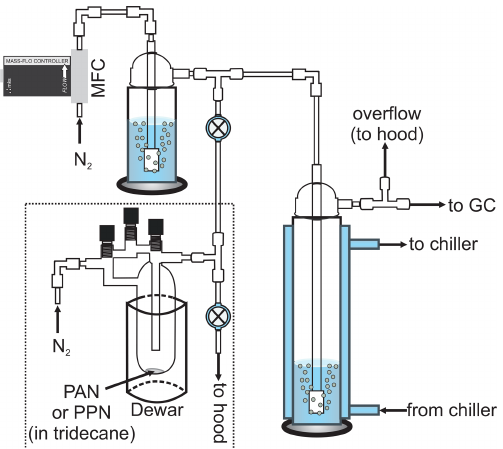
Figure 1. Schematic of the experimental apparatus (not to scale). The dashed line encompasses the PAN (or PPN) diffusion source. MFC: mass flow controller. The bubbler shown in the top left was removed for experiments with n